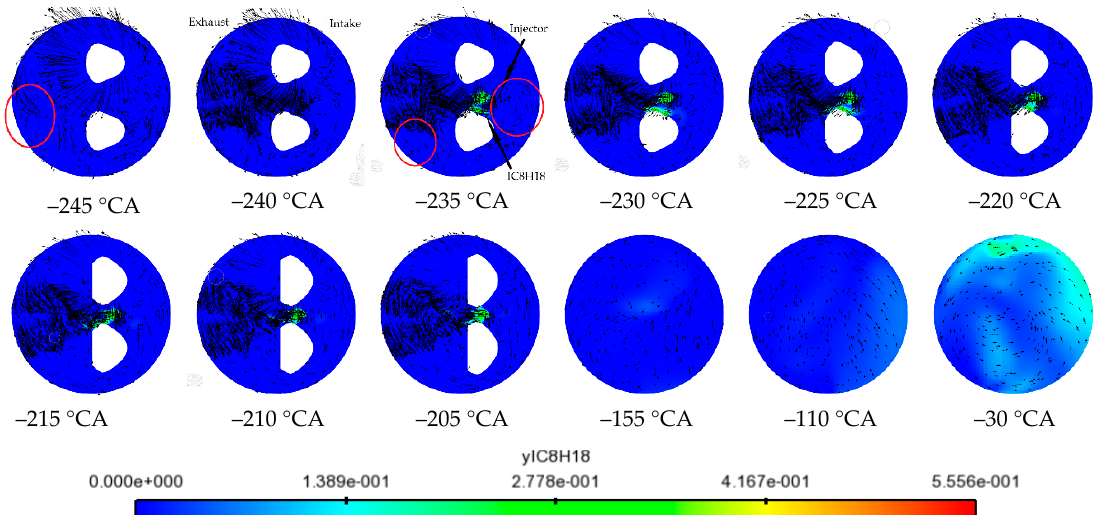
Figure 7. IC 8 H 18 spray cloud and instantaneous velocity field (perpendicular to the centerline of the cylinder and 1 mm from the top of the head).